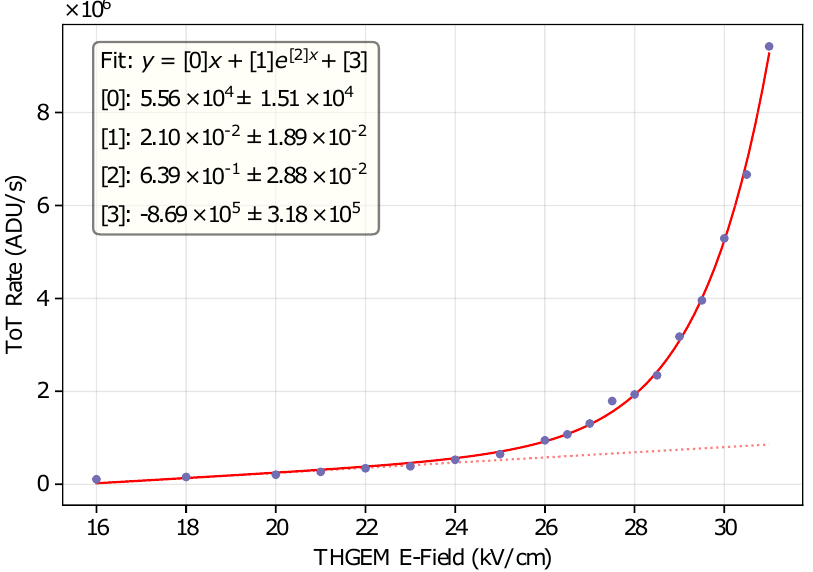
Figure 11. The TPX3Cam ToT rate as a function of the electric field across the THGEM. A single function as given in the legend has been fitted to the data, and the linear and exponential regimes (discussed in the main text) can be observed. Error bars have been omitted as they are within the datapoint